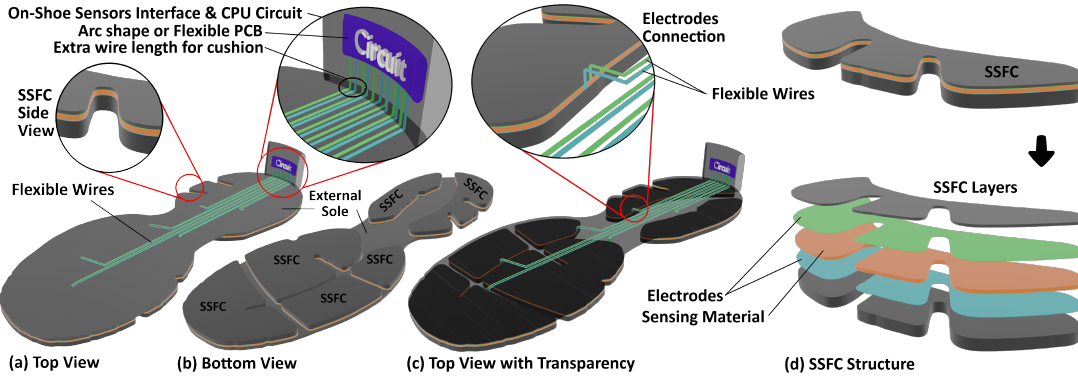
Figure 2. Custom Shoe Designs with 6 SSFCs.